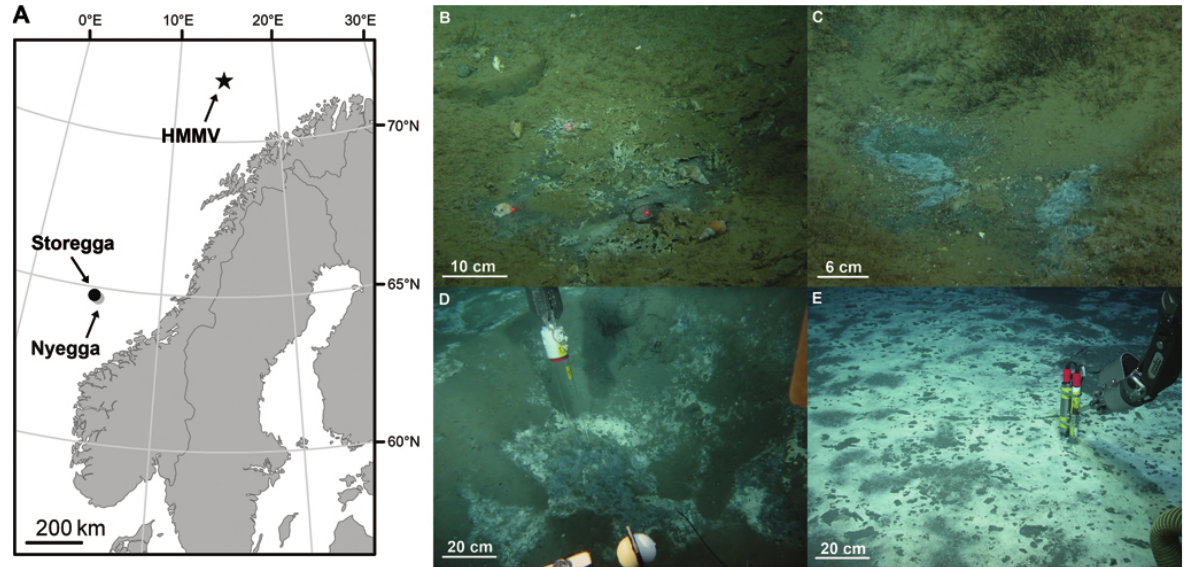
Fig. 1. Thiotrophic mats of the Norwegian margin. (A) Map of the study sites. (B–D) Gray mats at Storegga, Nyegga and the H˚akon Mosby mud volcano (HMMV). (Source: Ifremer, Vicking cruise 2006) (E) White mats at the HMMV. (Source: Marum, University Bremen, ARK- XXII/1b cruise